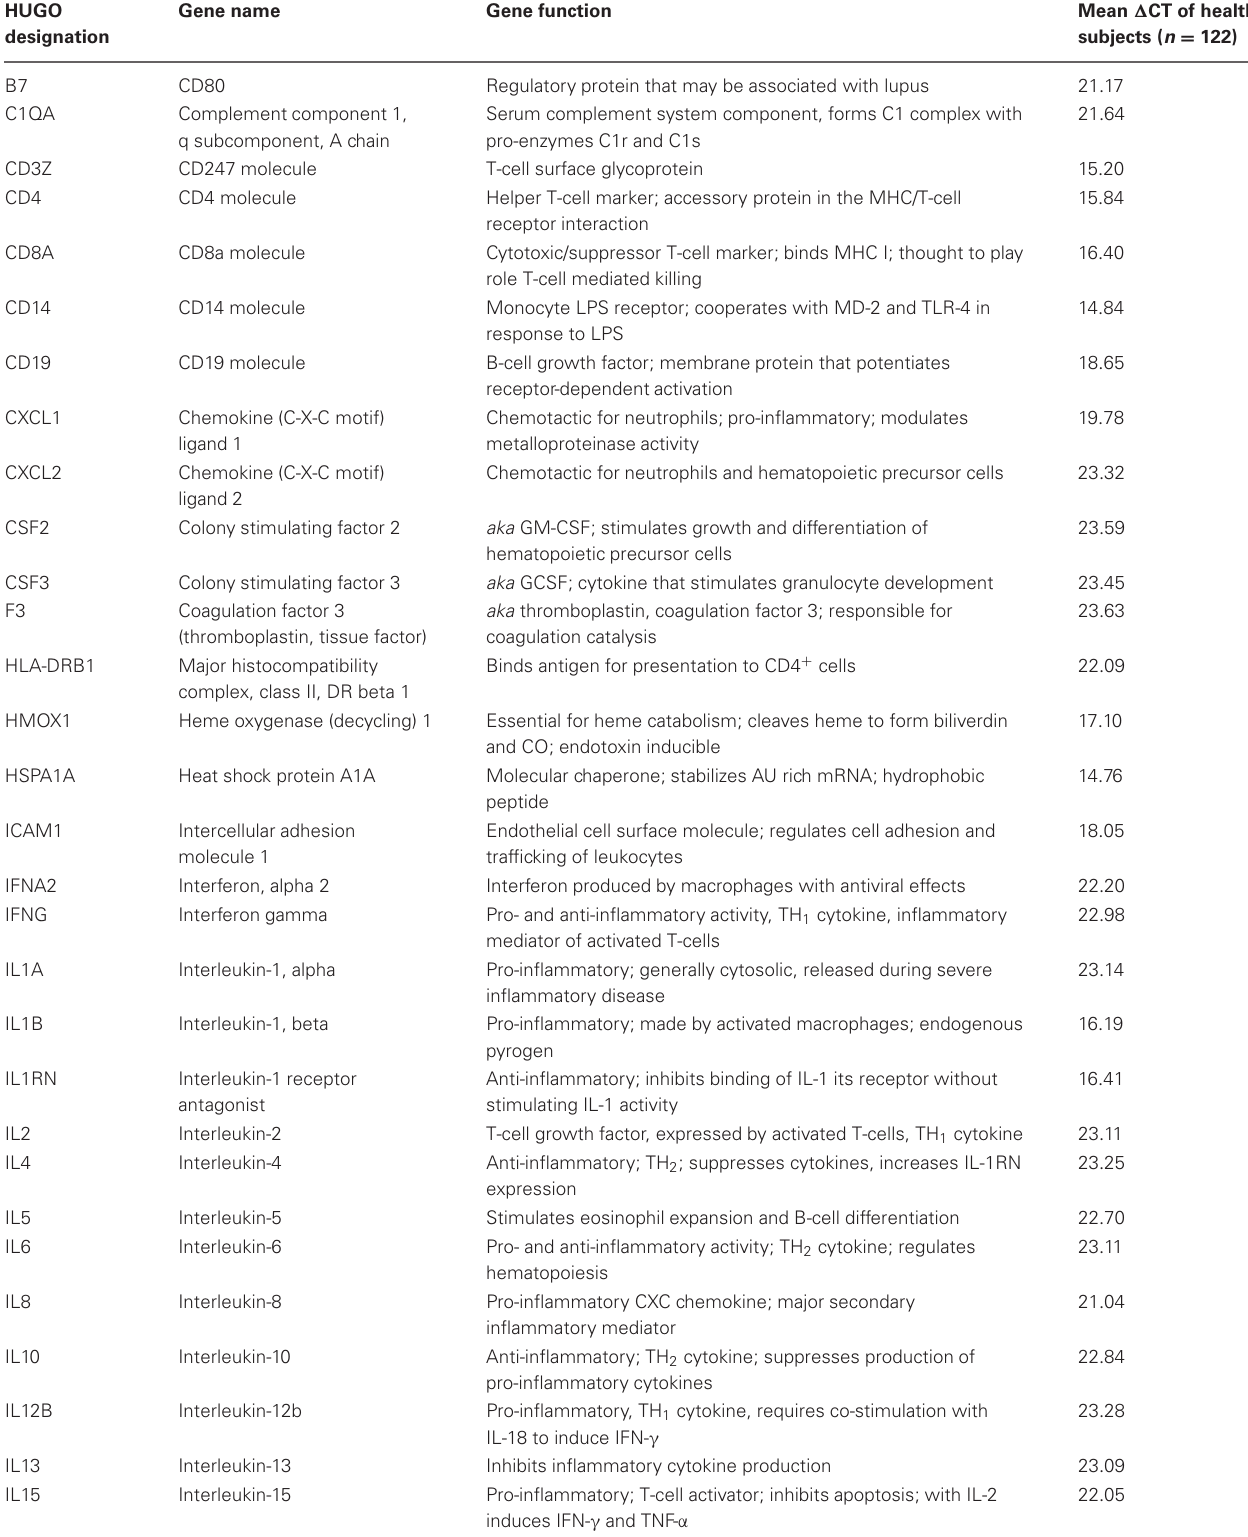
Table 2 | List of 48 inflammatory genes analyzed in the study and mean (cid:2) CT of gene expression in healthy subjects.